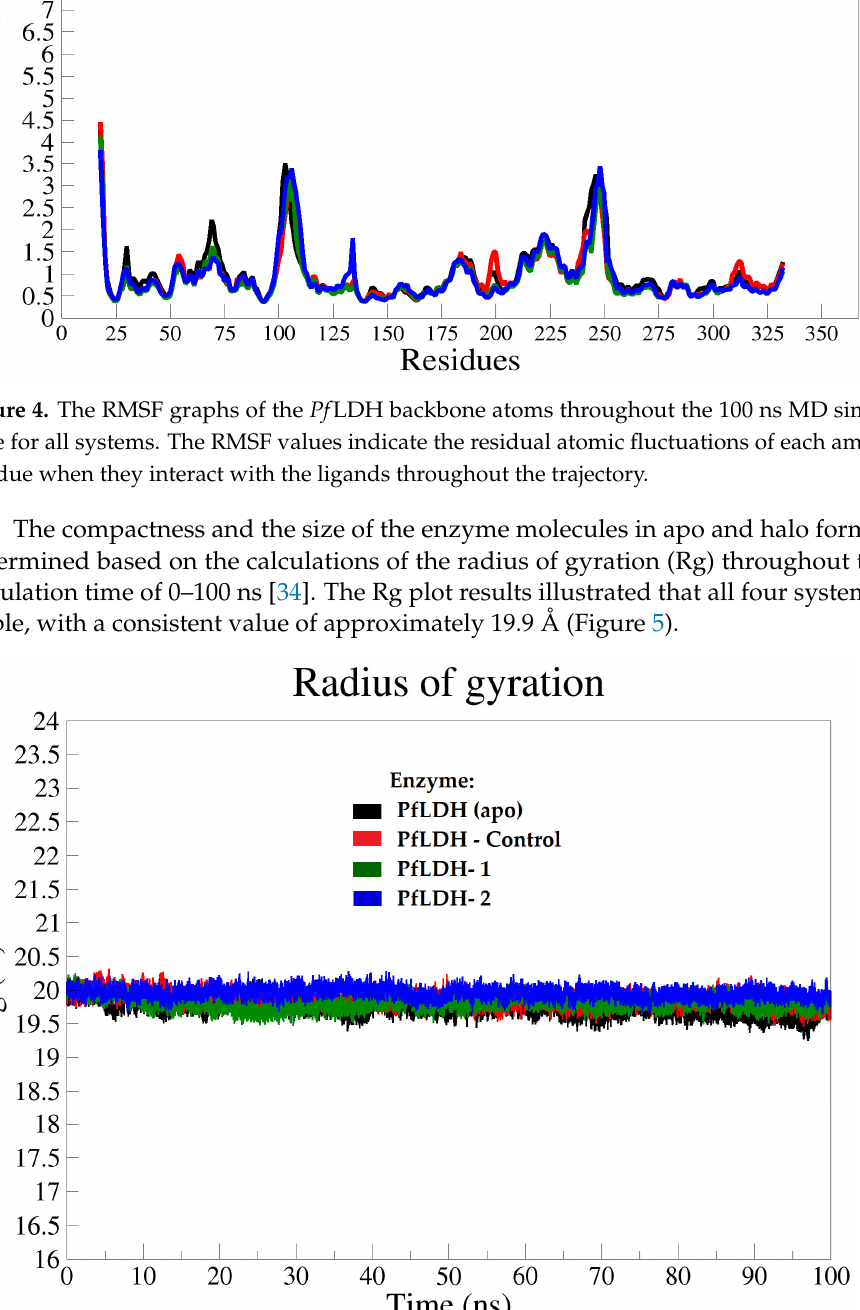
Figure 5. Radius of gyration (Rg) plots of the Pf LDH backbone atoms of all systems at MD interval time (0–100 ns); Apo ‐ Pf LDH (black), Pf LDH ‐ control (red), Pf LDH ‐ 1 (dark green), and Pf LDH ‐ 2 (blue).